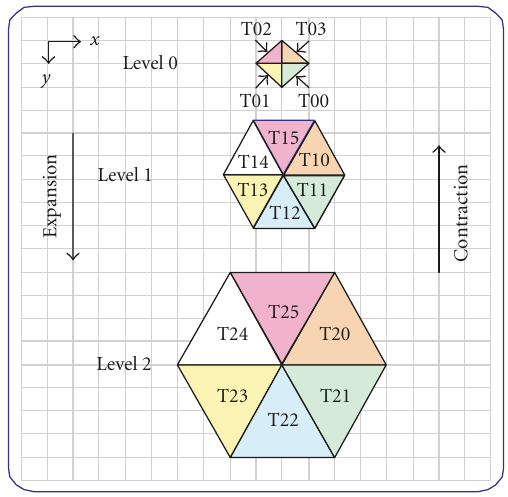
Figure 1: Triangle sets for levels 0 to